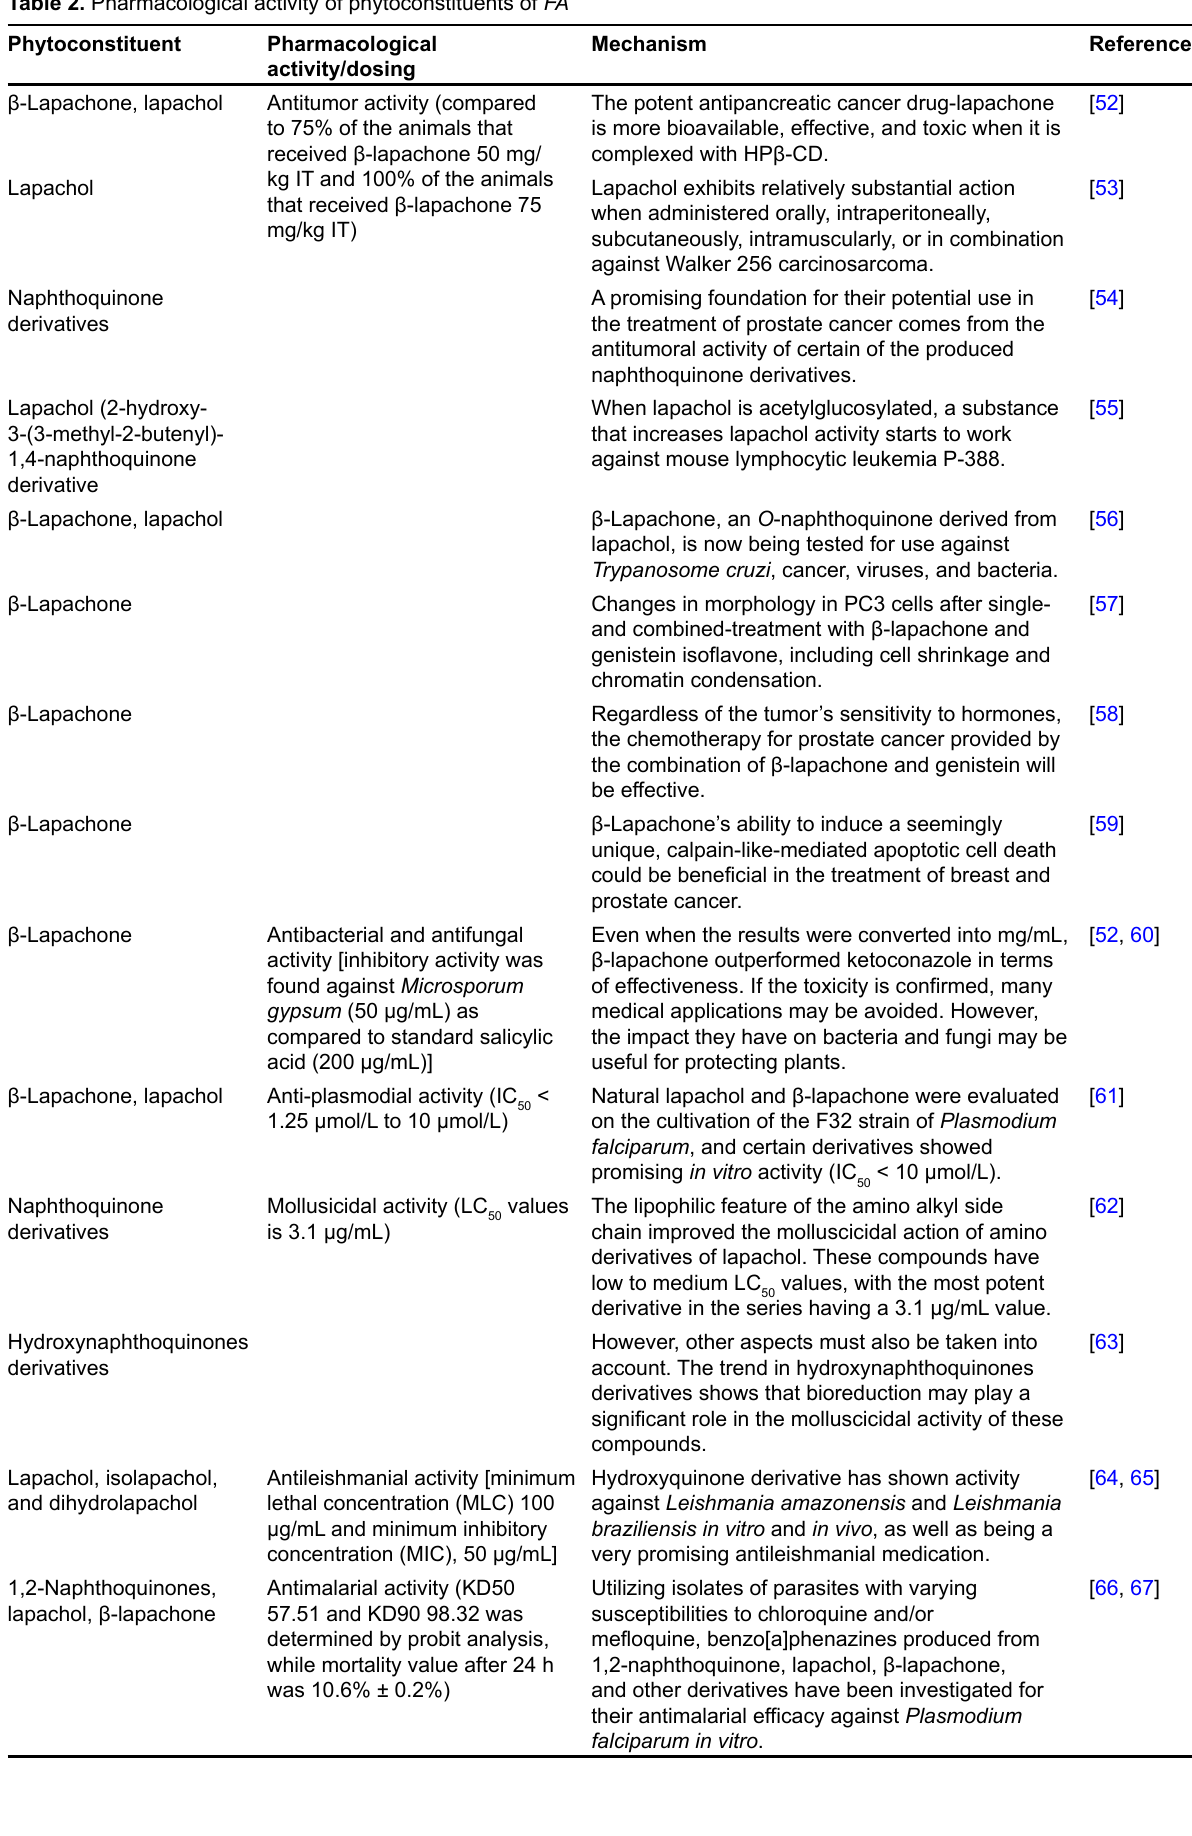
Table 2. Pharmacological activity of phytoconstituents of